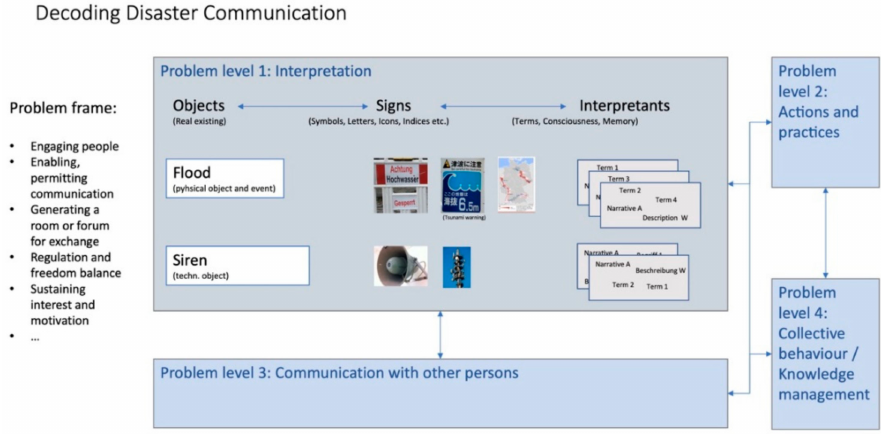
Figure 3. Decoding transfer of knowledge problems in flood